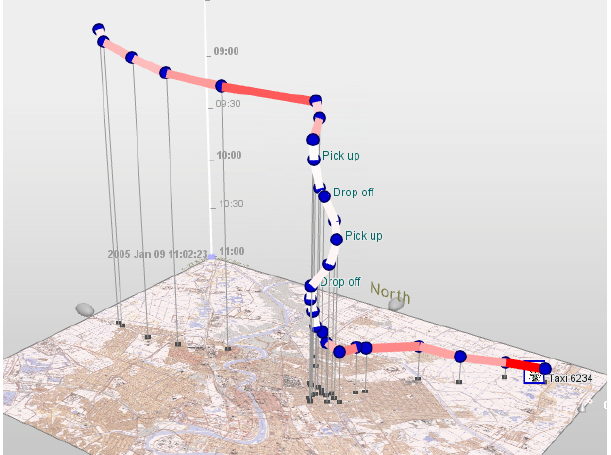
Figure 10. Eccles et al. show a GeoTime visualisation instance. The l -axis represented by height is temporal. x - and y -axis represent the geospatial location Here you can see a taxi driver’s route over the course of a few hours. Each pick up and drop off is labelled and the route is mapped on the x- and y -axis using the map [26]. Image courtesy of Eccles et al.